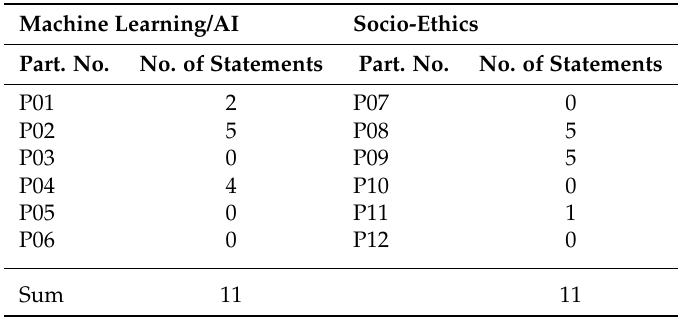
Table 6. Number of statements per interviewee related to being